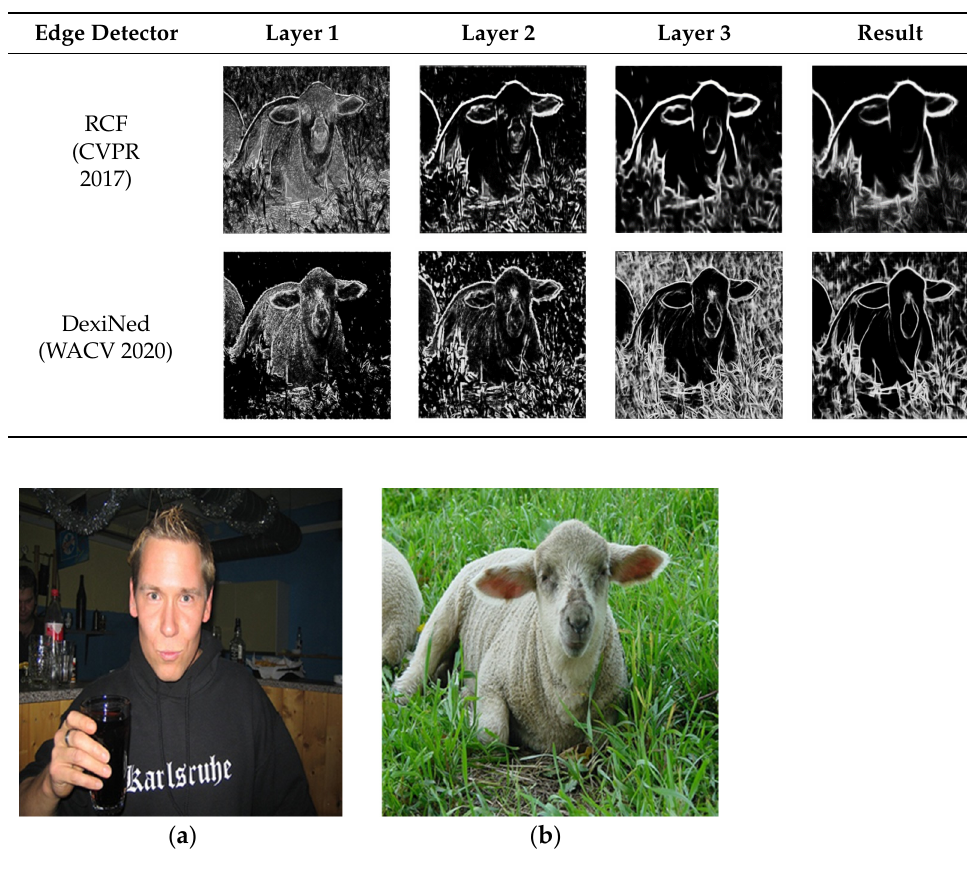
Table 3. Edge images generated by each edge detector for color image in Figure 2b.